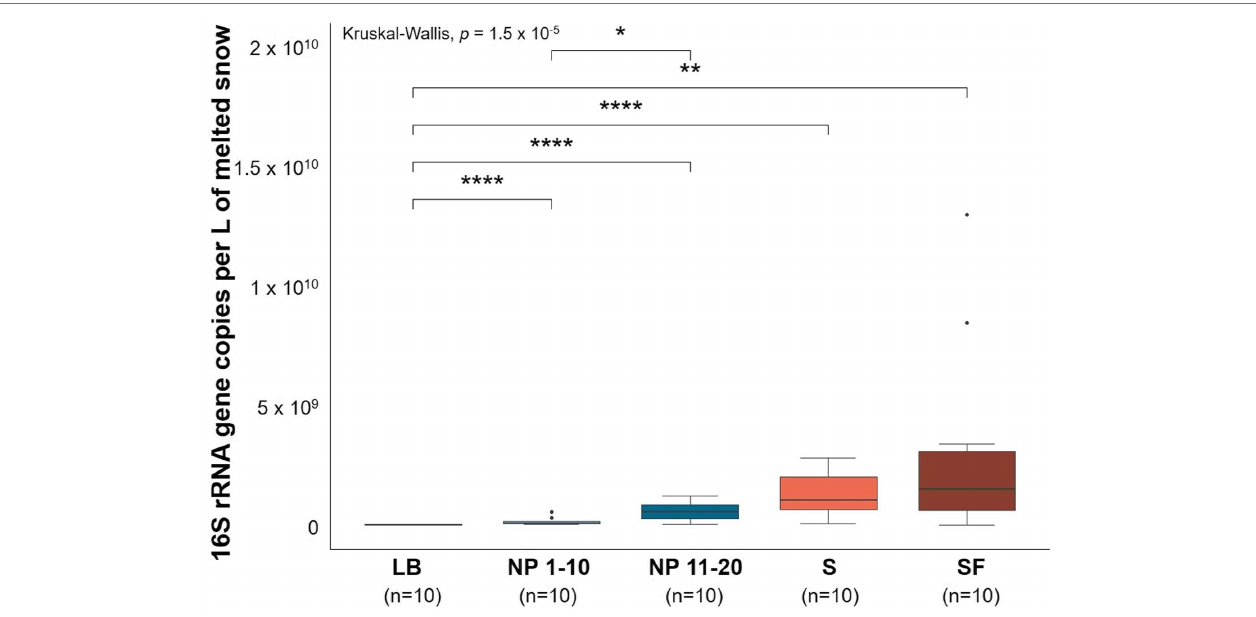
FIGURE 1 | Estimates of bacterial biomass based on qPCR of the 16S rRNA gene from all sites. LB: ridge from the catchment with human transit. NP 1–10: open spaces from the unaffected catchment. NP 11–20: forested area from the unaffected catchment. S: paths from the catchment with human transit. SF: forest areas from the catchment with human transit. Copies were normalized per L of melted snow. qPCR efficiency = 1.04. R 2 linearity coefficient = 0.986. Data normality was checked using the Shapiro–Wilk test ( p = 5.03 × 10 − 12 ). Significant differences between sites were determined by pairwise Wilcoxon signed-rank tests. * p ≤ 0.05,